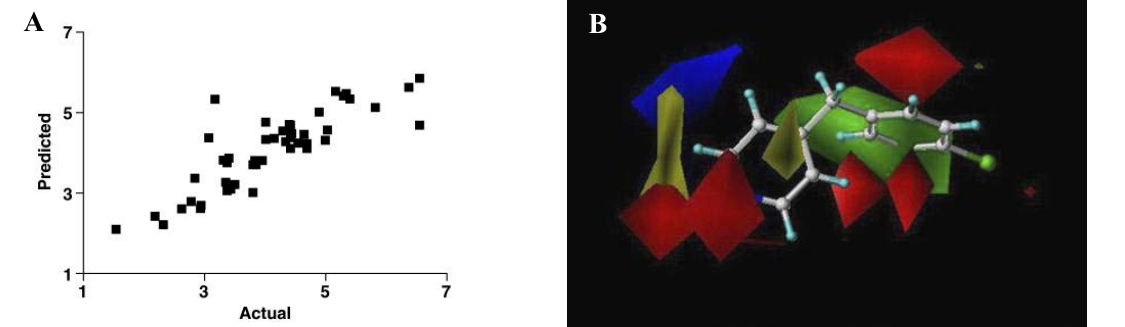
( B ) Color contour maps of final CYP2B6 CoMFA model. Areas where more negative partial charge and bulkier groups favor an increase in inhibition potency are represented in red and green colors, respectively. Blue and yellow represent areas where more negative partial charge and bulkier groups favor a decrease in inhibition potency, respectively. The reference structure is 4-(4-chlorobenzyl)pyridine. Figure 4A,B were adapted from reference